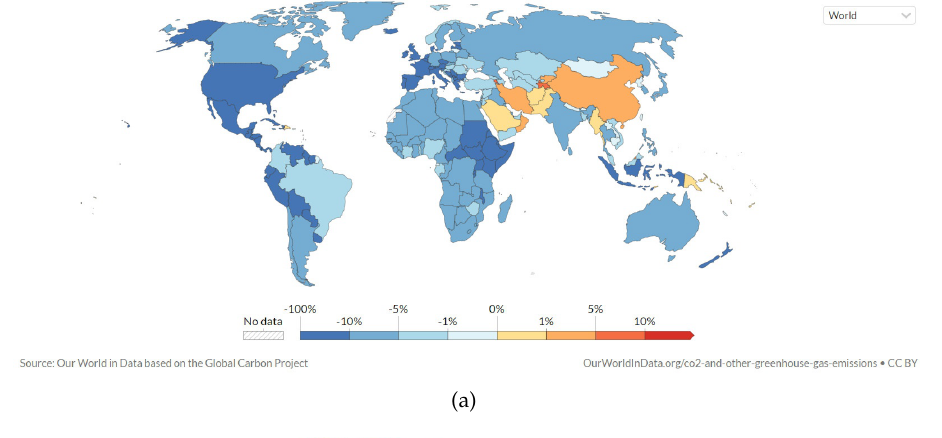
Figure 1. Annual change in primary energy consumption: (a) 2020, (b) 2021.